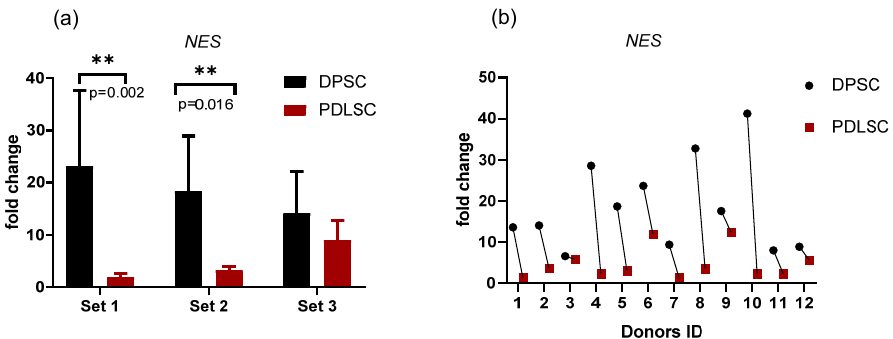
Figure 2. Nestin gene ( NES) transcription in PDLSC and DPSC quantified by qPCR: comparison between samples obtained from the same donor. ( a ) Average values (mean and standard deviation) obtained in three different experiments (set 1, set 2, set 3; n = 4 in each set); ( b ) the values for each donor (donors ID are plotted on the X -axis) are shown to demonstrate the variability between donors. Y -axis—fold change. The reference gene— GAPdH . **— p < 0.01 (the exact p -values are also shown).